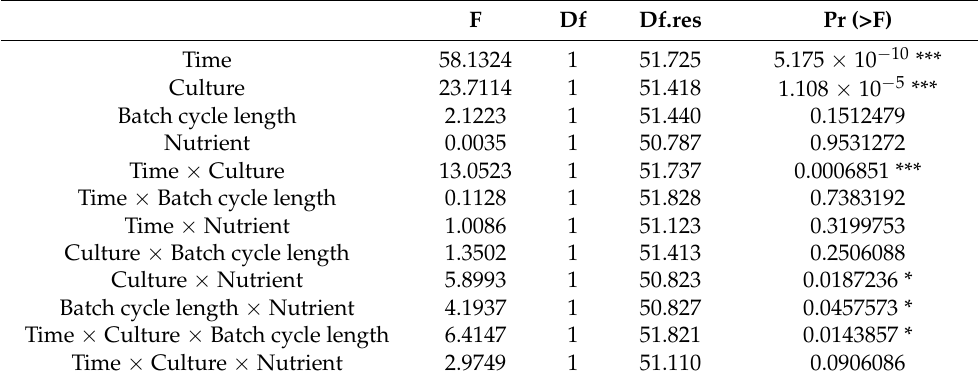
Table 3. Analysis of deviance table of Type II Wald F tests with Kenward-Roger df for linear mixed- effects model using the proportion of E. huxleyi genotype C91 as response variable. Stars show significance level of the test; *** p < 0.001 and * p < 0.05.